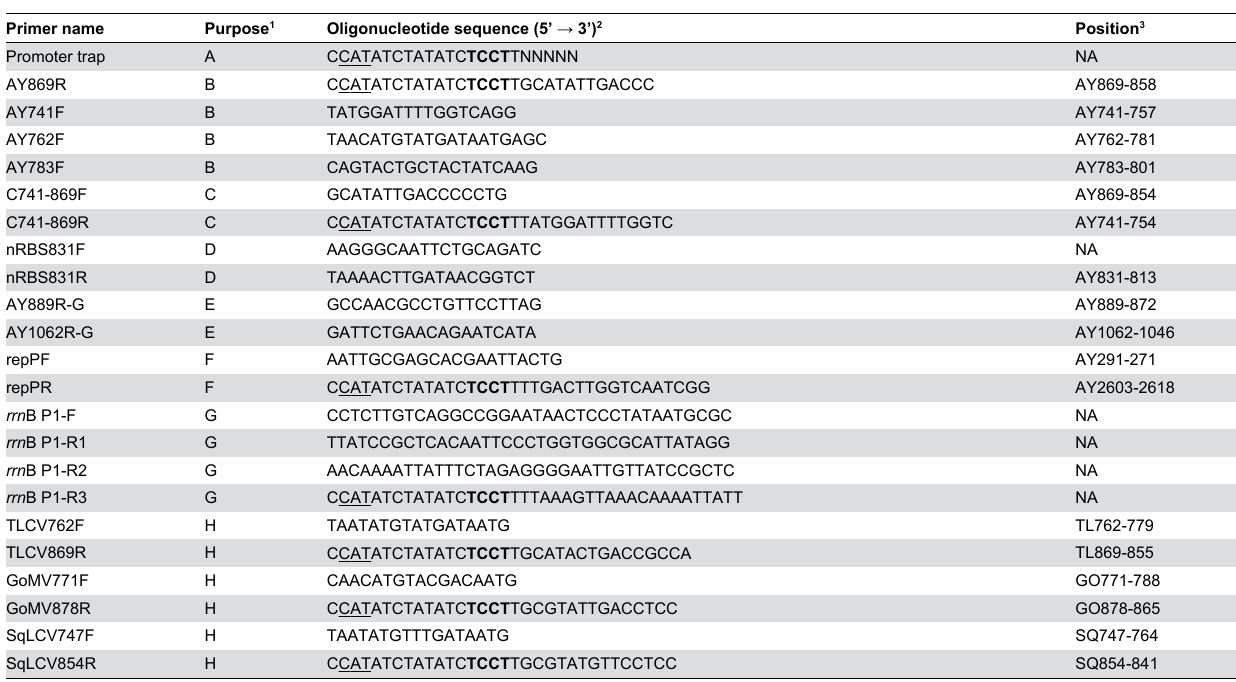
Table 1. Primers used in this